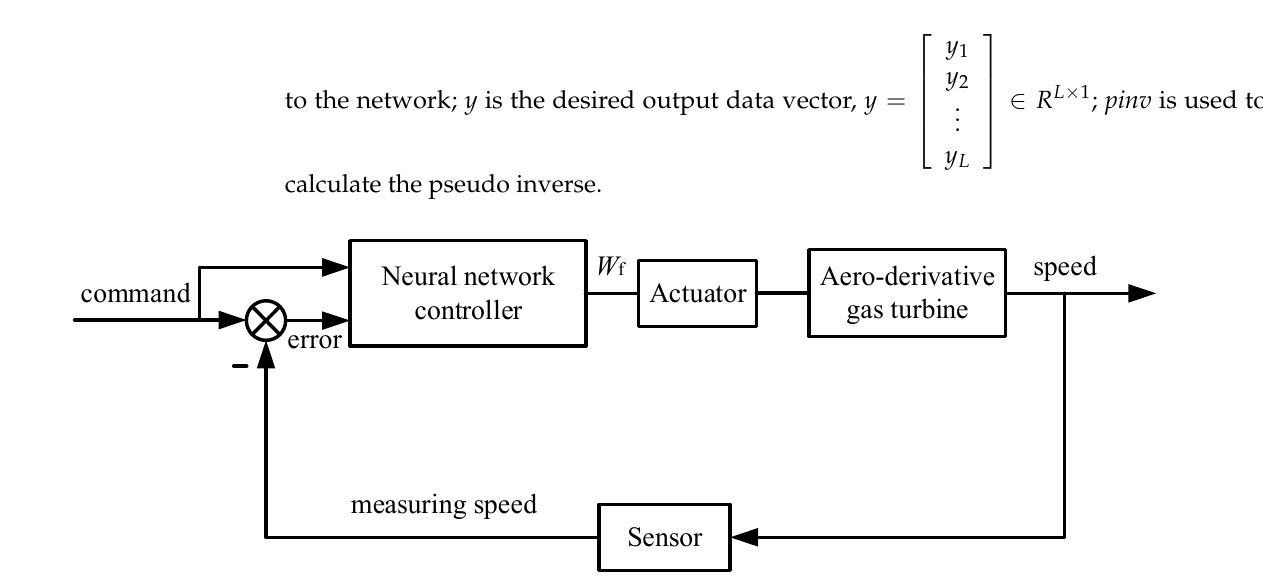
Figure 3. The entire control system of aero-derivative gas turbine using neural network controller.